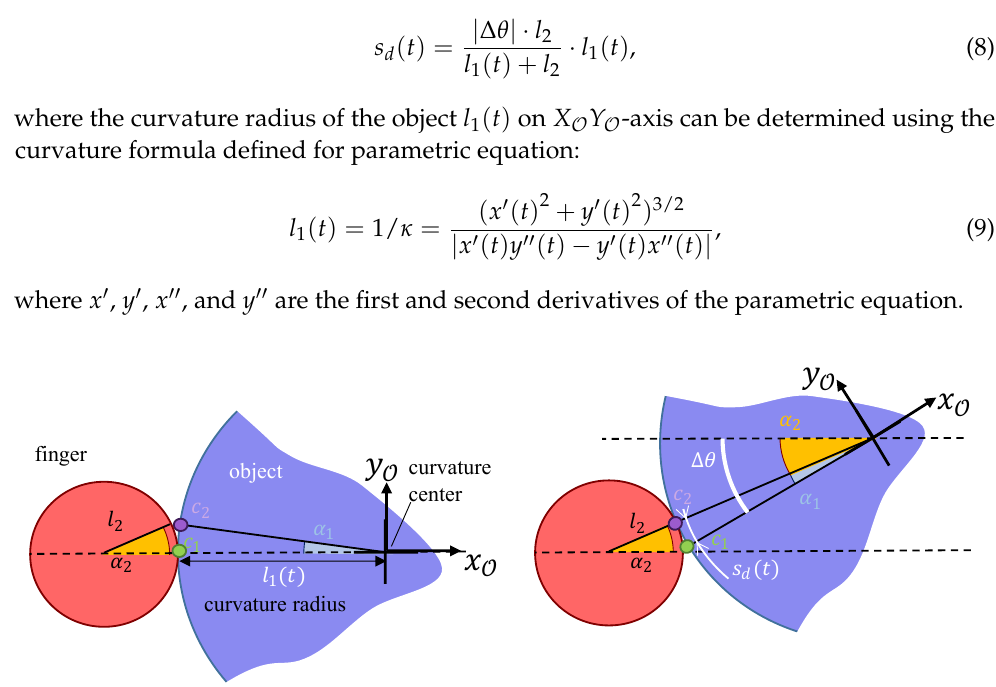
Figure 3. Representation of finger rotating an object to formulate the sampling